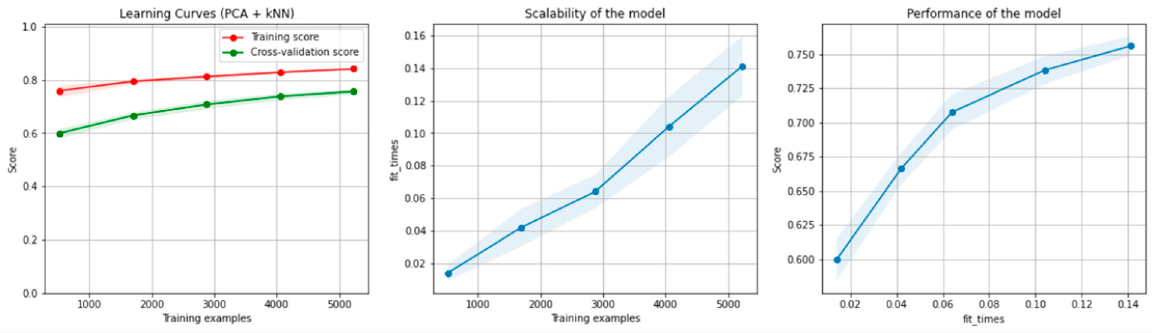
Figure 17. Learning curves, scalability and model performance for the PCA + kNN algorithm, for the overlapping dataset.